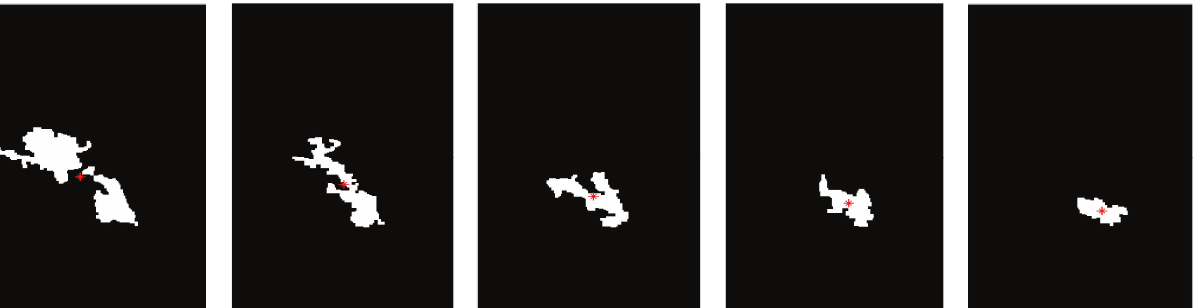
Figure 4: Centroid motion direction of smoke